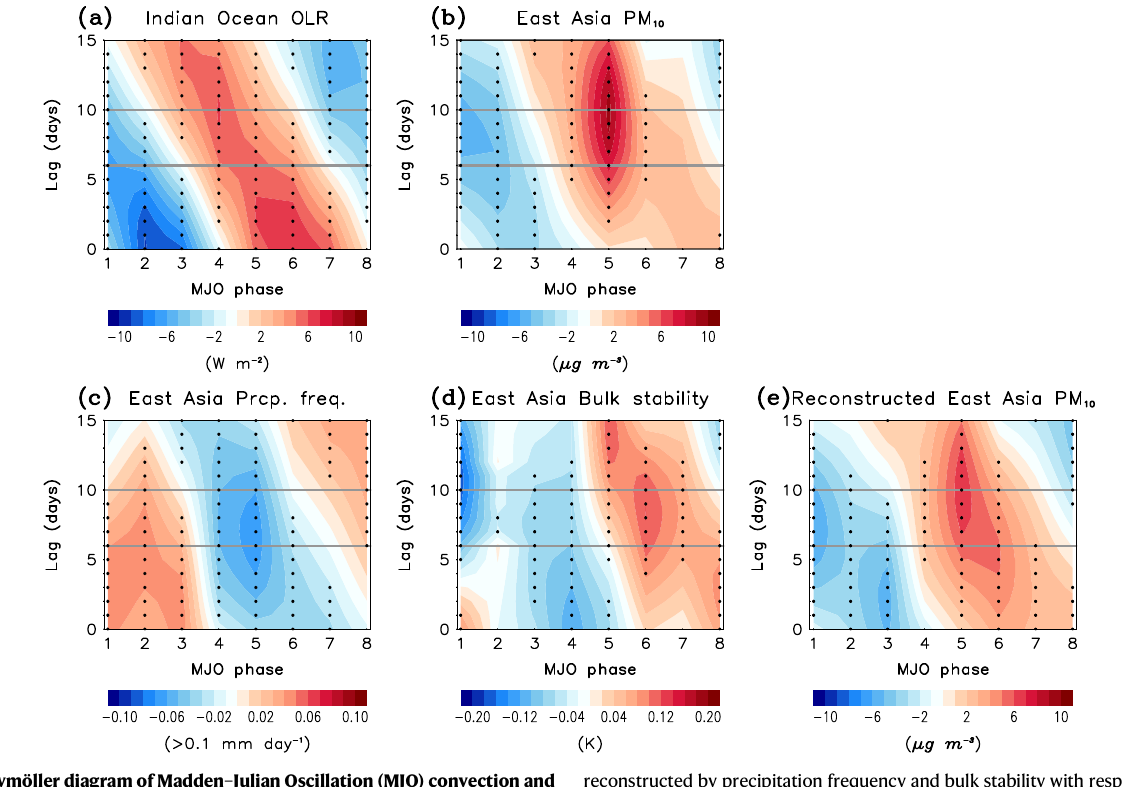
reconstructed by precipitation frequency and bulk stability with respect to the Madden – Julian Oscillation (MJO) phase and time lag. Values that are statistically signi fi cant atthe 95%con fi dencelevelare indicatedwith blackdots. The gray